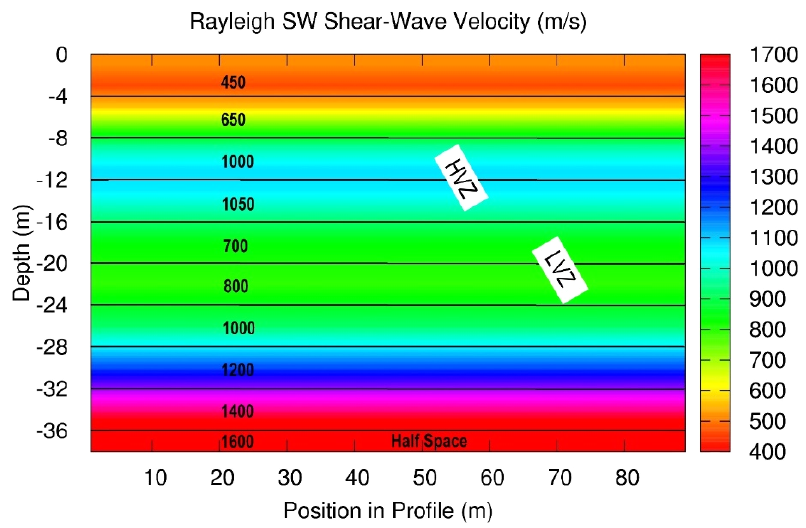
Figure 11. The inverted cross section of the shear-wave velocities for the model structure in Table 2 is